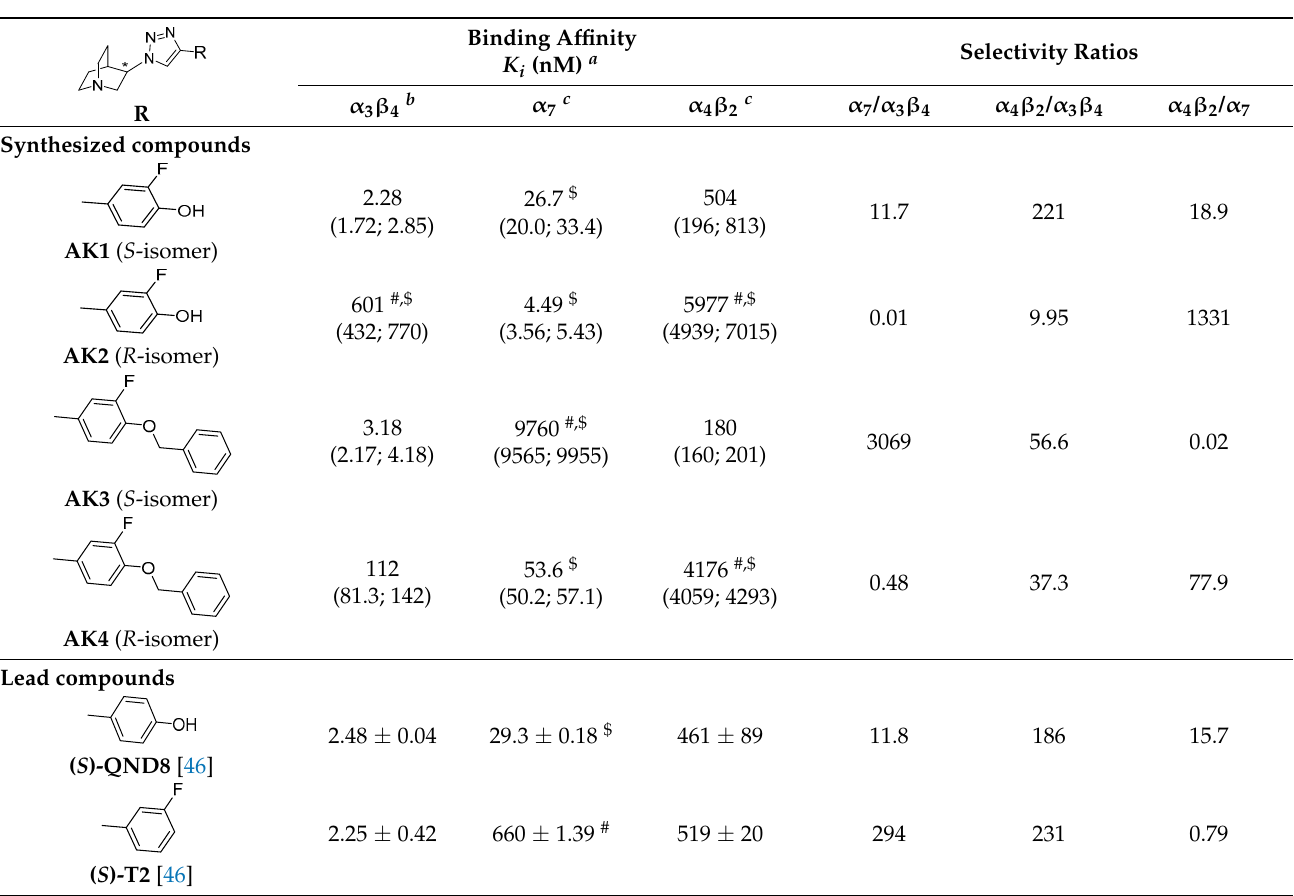
Figure 2. The design strategy of α 3 β 4 nAChR ligands. Table 1. In vitro binding affinity constants ( K i values) for binding of the quinuclidine-triazole derivatives towards human α 3 β 4 , α 4 β 2 , and α 7 nAChRs a .